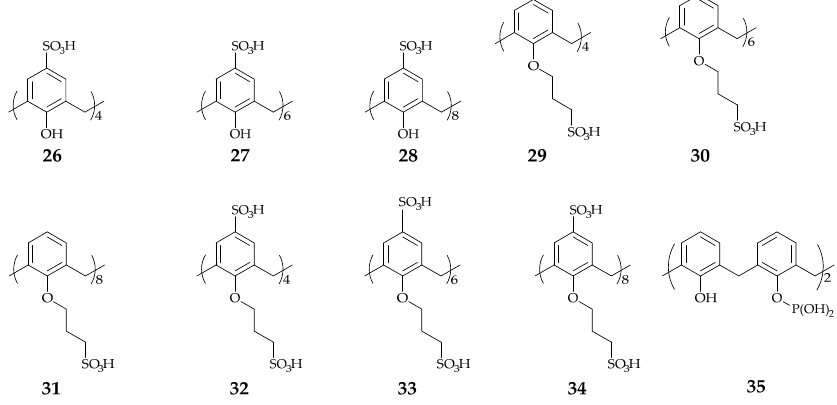
Figure 5. Structures of calix[4]arene derivatives 26 – 35 .